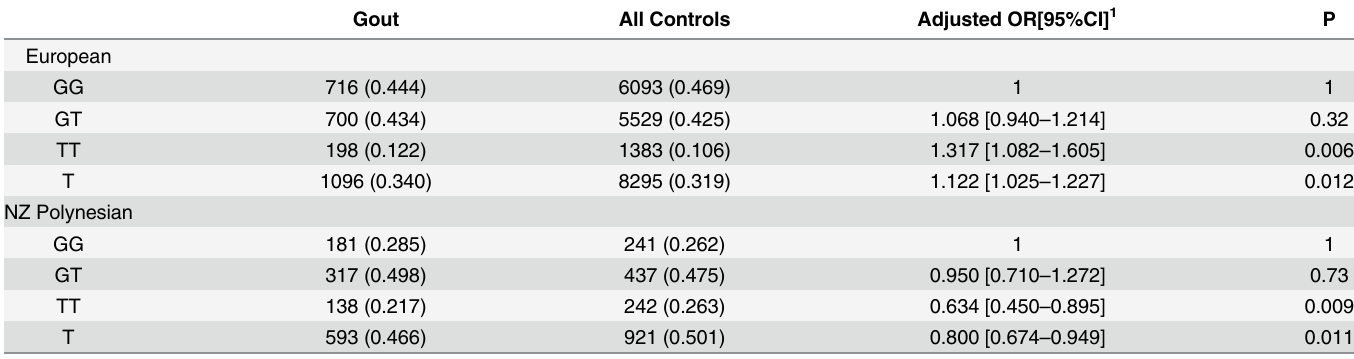
Table 2. Rs2149356 genotype and association with risk of gout in NZ and Europe sample sets using ARIC and FHS